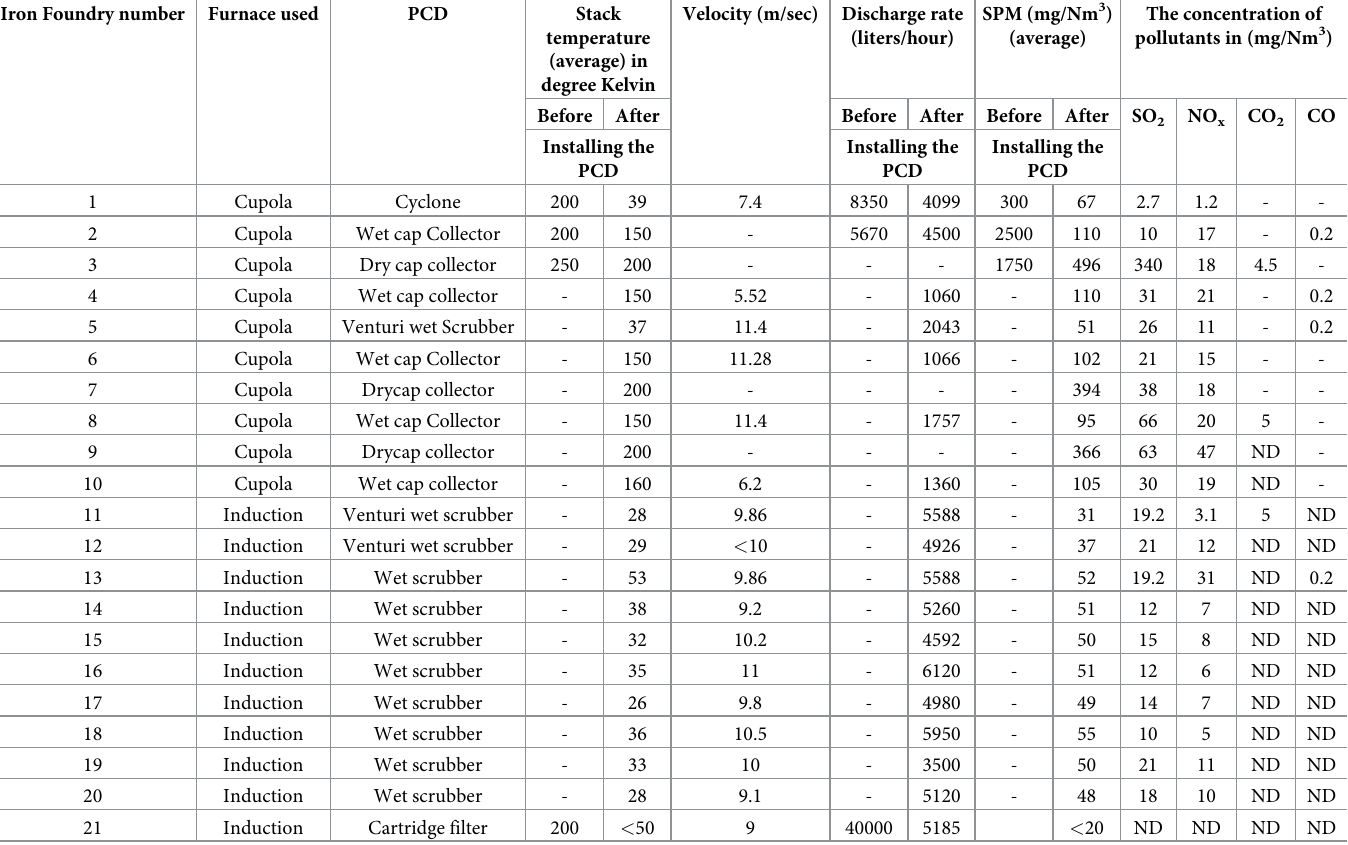
Table 2. PCDs installed in foundries of Tamilnadu state and their impact on pollution prevention. Iron Foundry number Furnace